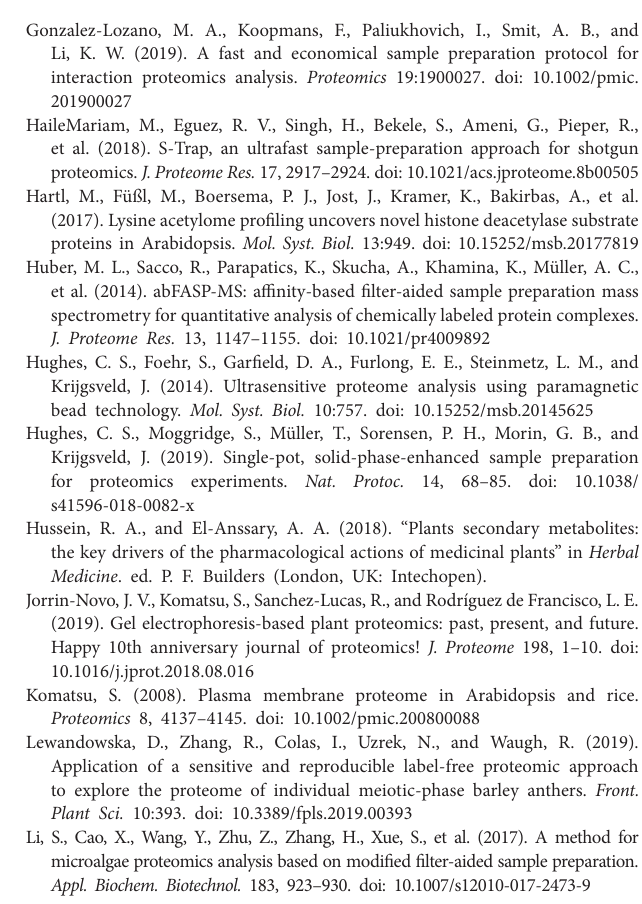
SP3 Protocol for Proteomic Plant